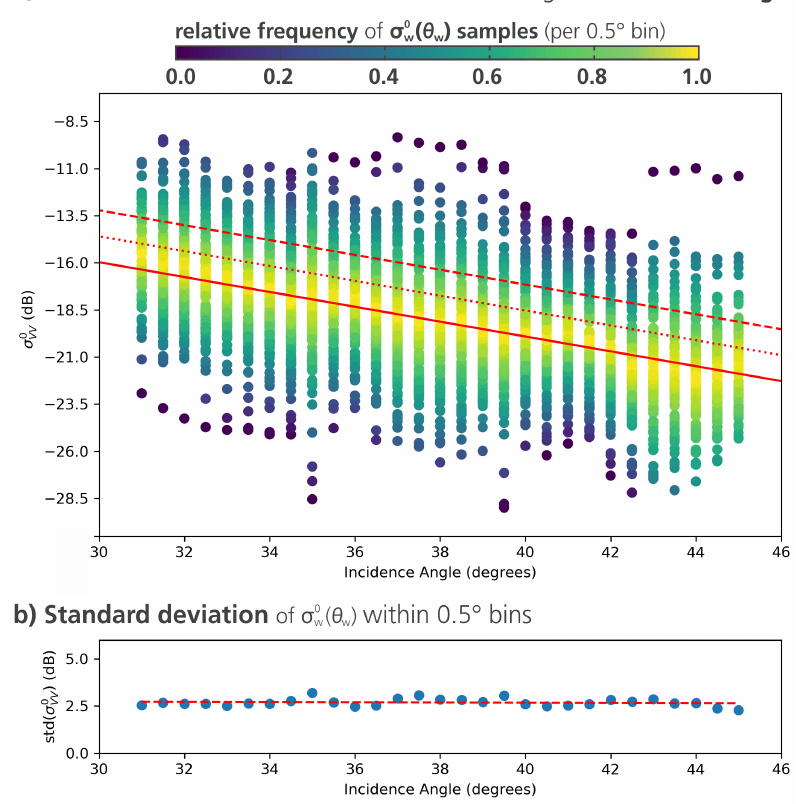
Figure 2. ( a ) Scatterplot of collected Sentinel-1 backscatter coefficients σ 0 w ( θ w ) over water surfaces against incidence angles θ w , arranged within 0.5 ◦ incidence angle bins. The solid red line is the fitted linear function, while the dashed red line indicates one standard deviation, and the dotted line half of the standard deviation (used for masking in Section 2.5.2). ( b ) Standard deviation of backscatter coefficients within the respective incidence angle